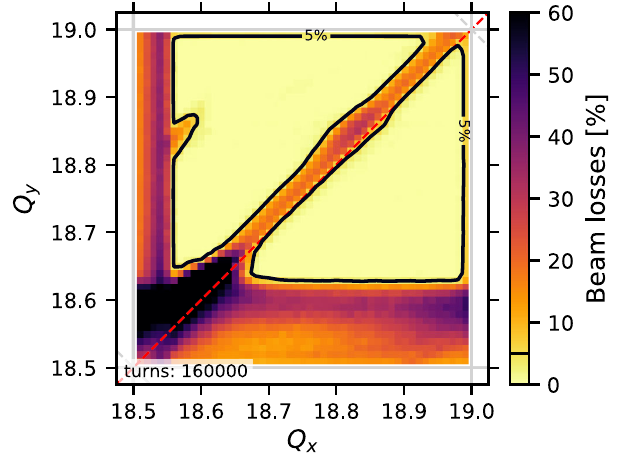
FIG. 3. Corrected warm quadrupole magnets. Beam-loss tune diagram with FFSC simulation